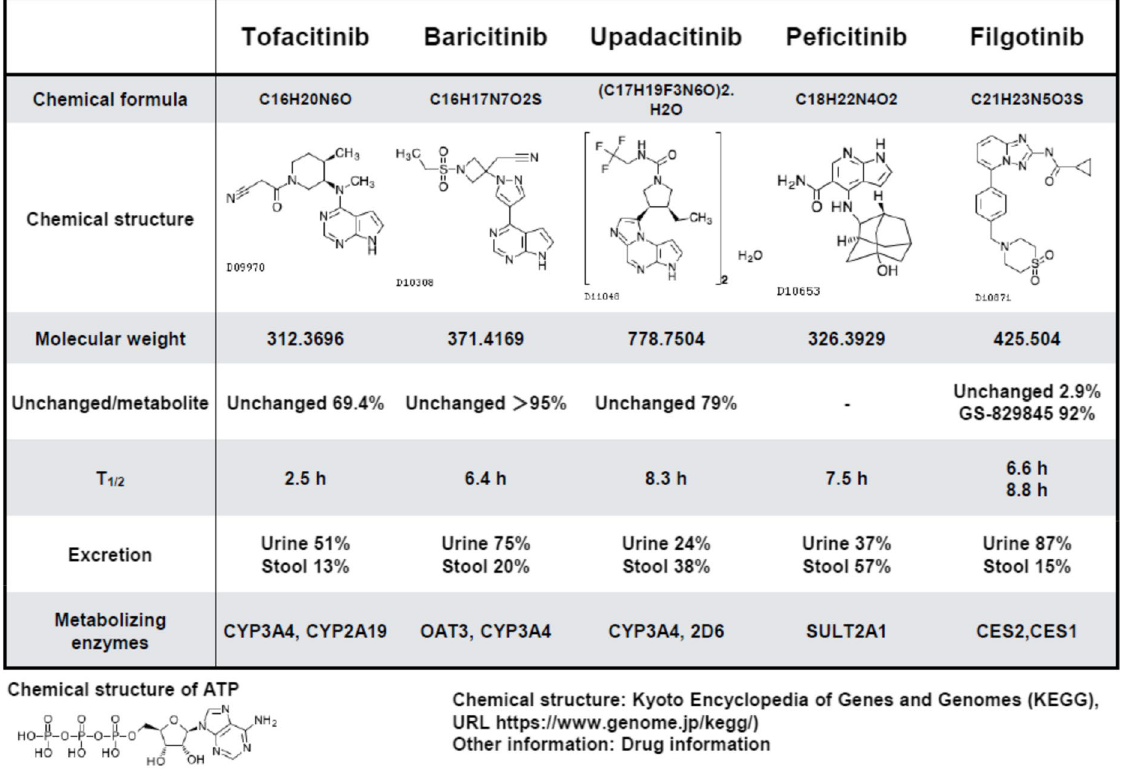
Table 2 Structure of JAK inhibitors in immune-mediated inflammatory